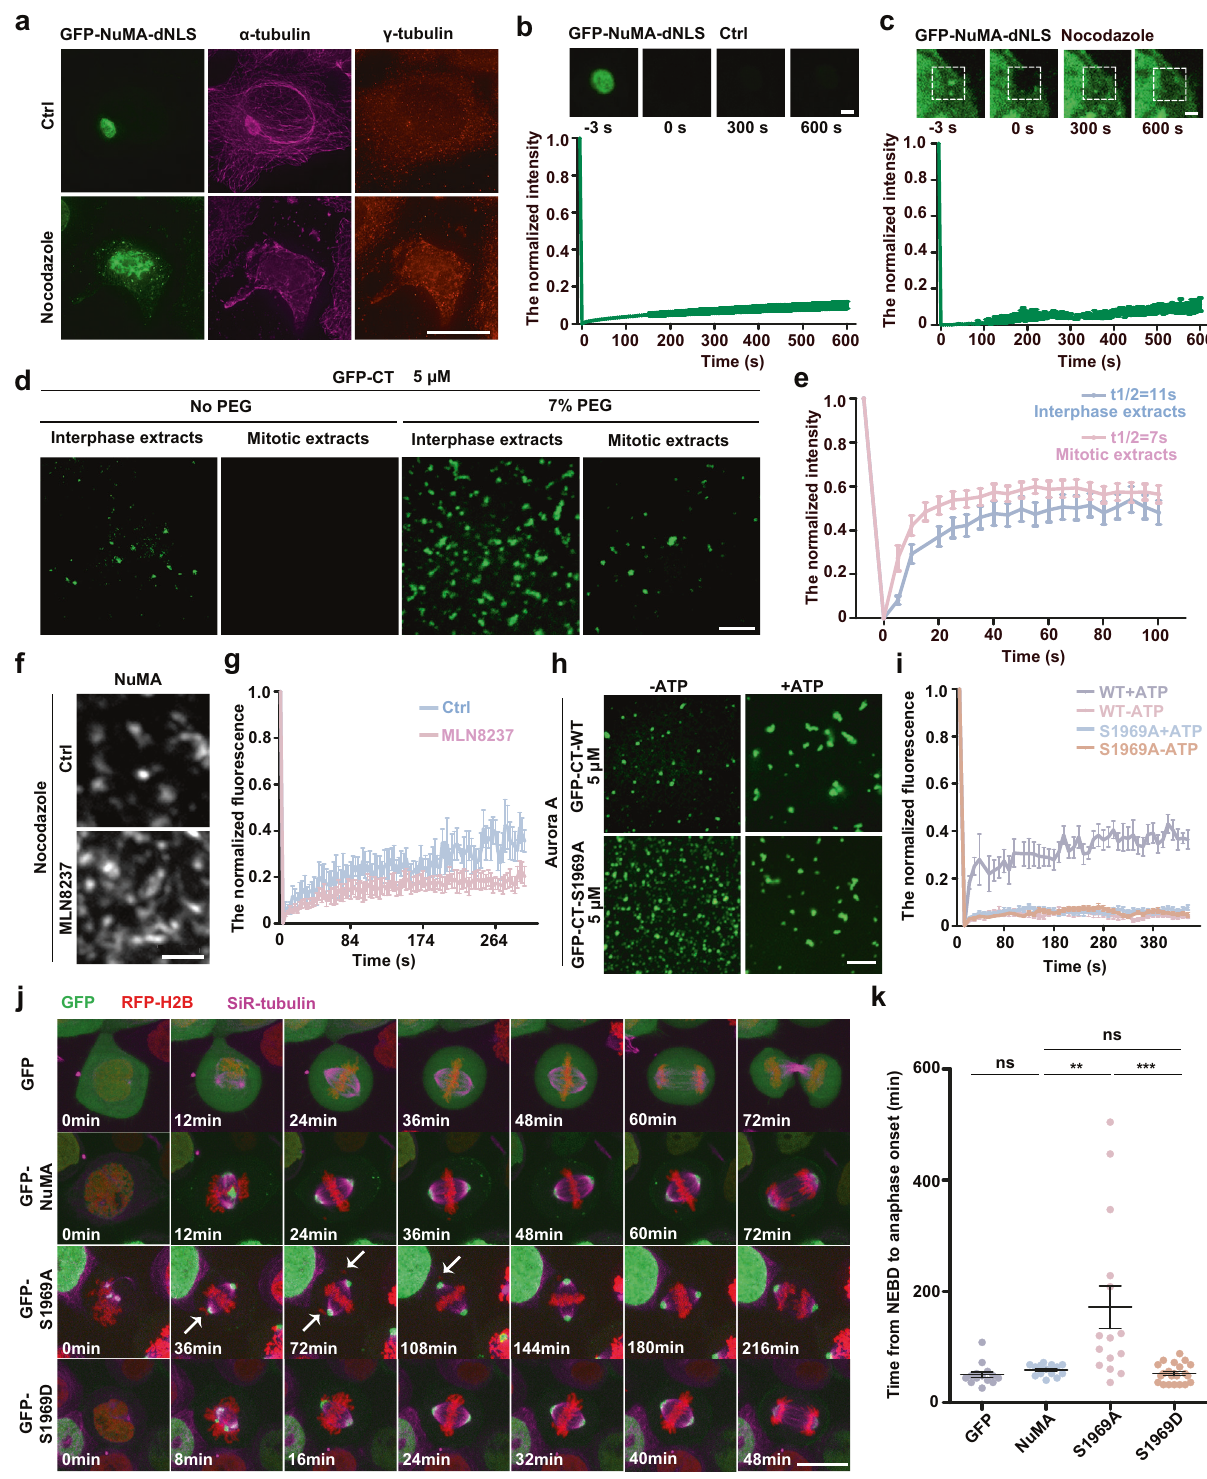
poles during early mitosis. To compare the status of NuMA between interphase and mitosis so as to fi nd the regulating mechanism, we generated and expressed GFP-tagged NLS (nuclear localization sequence)-deleting NuMA mutant (GFP- NuMA-dNLS) in HeLa cells. The results showed that GFP- NuMA-NLS was solely localized to the cytoplasm and formed large microtubule-containing spherical droplets; and when microtubules were depolymerized by nocodazole treatment, these NATURE COMMUNICATIONS| (2021) 12:7157